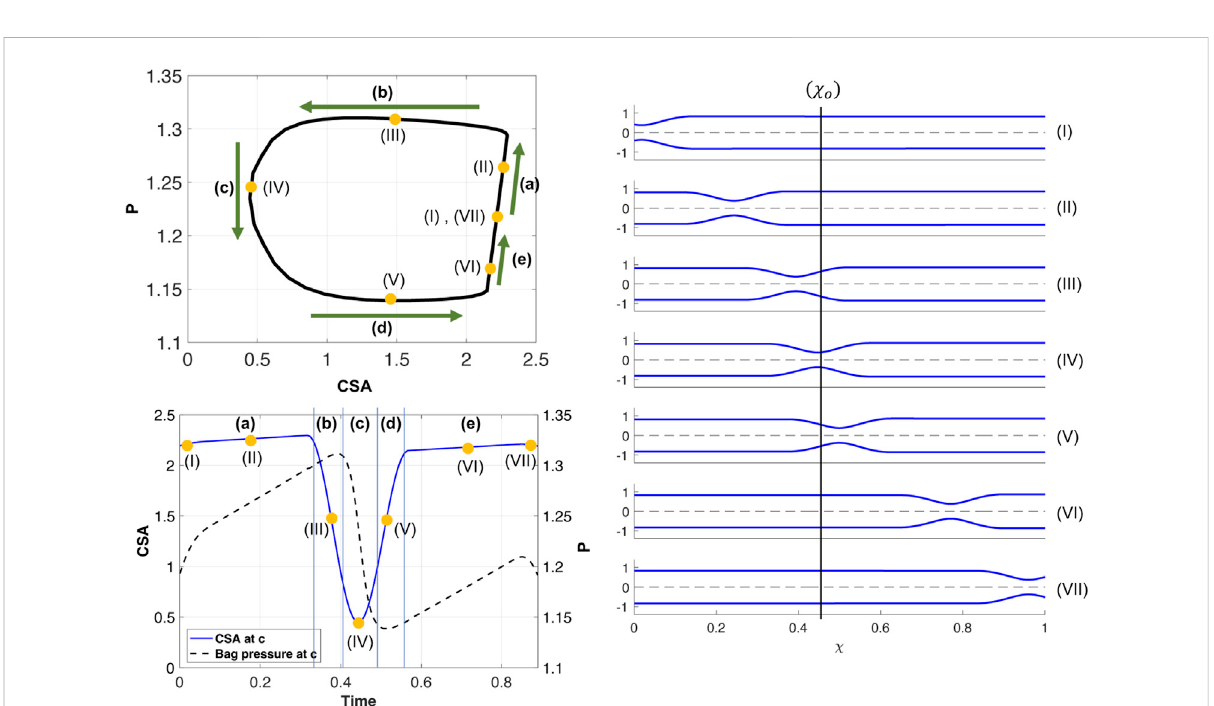
FIGURE 4 Simulationresultsforasinglecontractioncyclewithmuscleactivityde fi nedbyatravelingperistalticwave( θ p ).Topleft:P-CSAhysteresisloopat χ o . Bottom left: P and CSA vs. time at χ = χ o . Right: tube shape at seven consecutive instants, ordered chronologically.